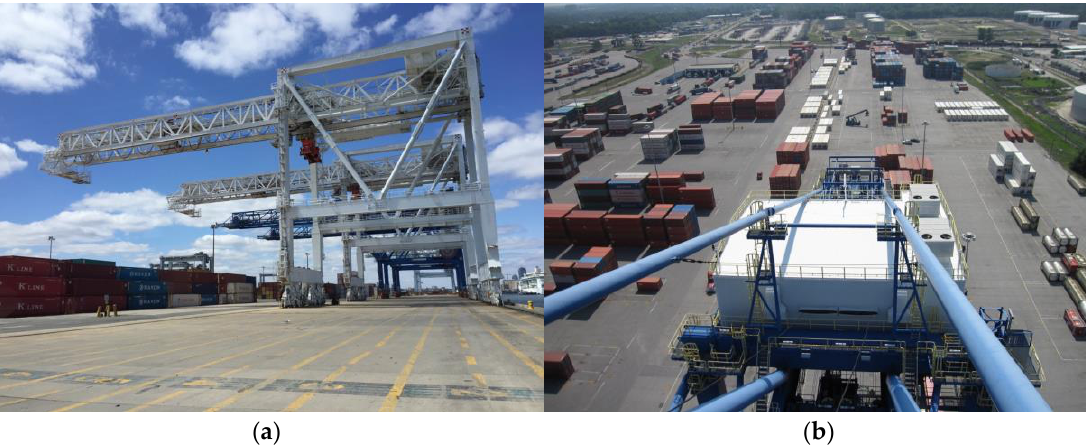
Figure 2. ( a ) Photograph of the “Apron” area at the Port of Boston; and ( b ) photograph of primary (to right) and secondary (to left) yards in Wilmington, North Carolina (photos by A. Becker).